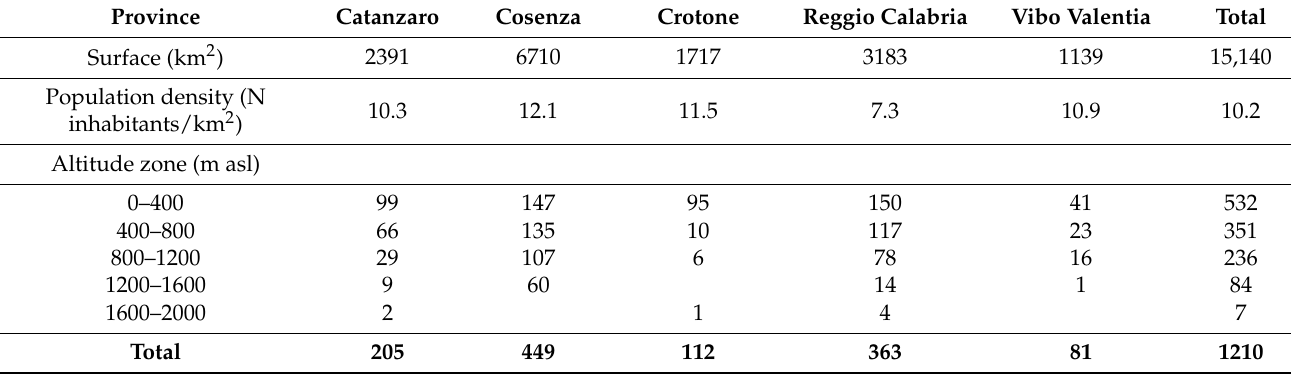
Table 1. Number of phytotoponyms by province and altitude